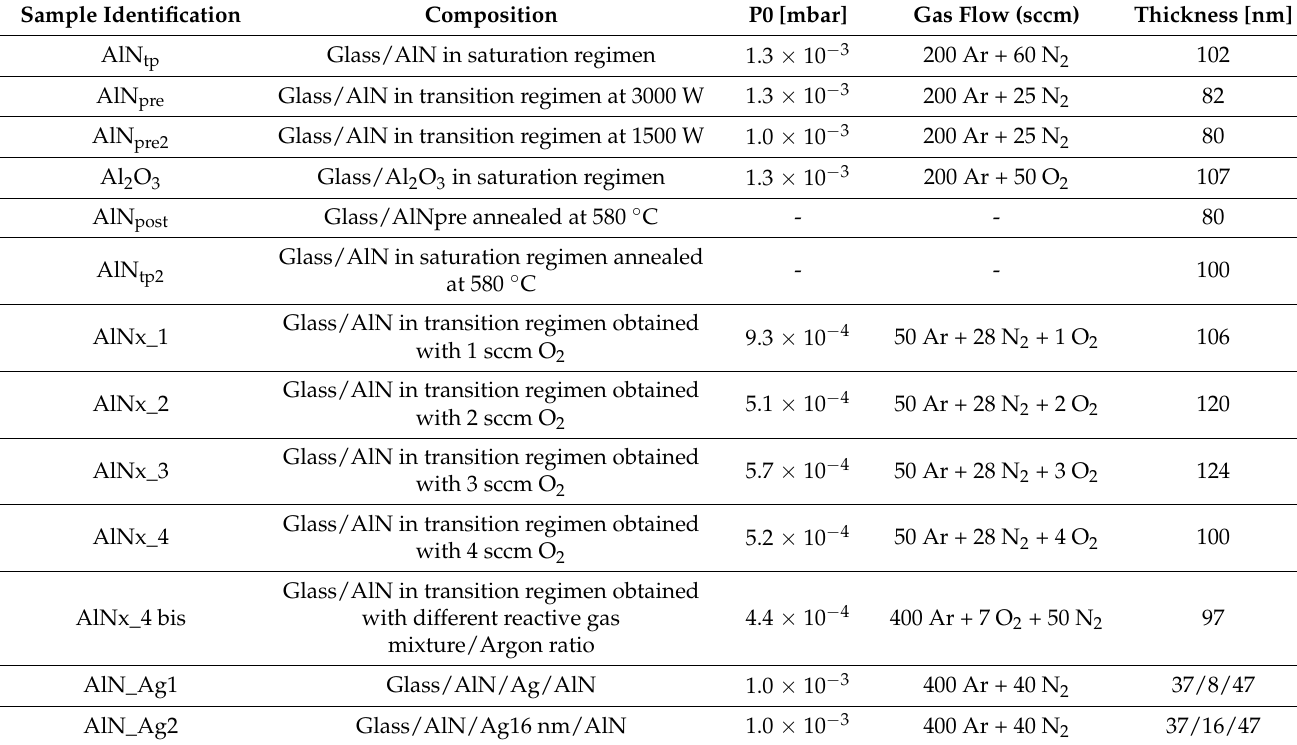
Table 1. Sample nomenclature and experimental fabrication